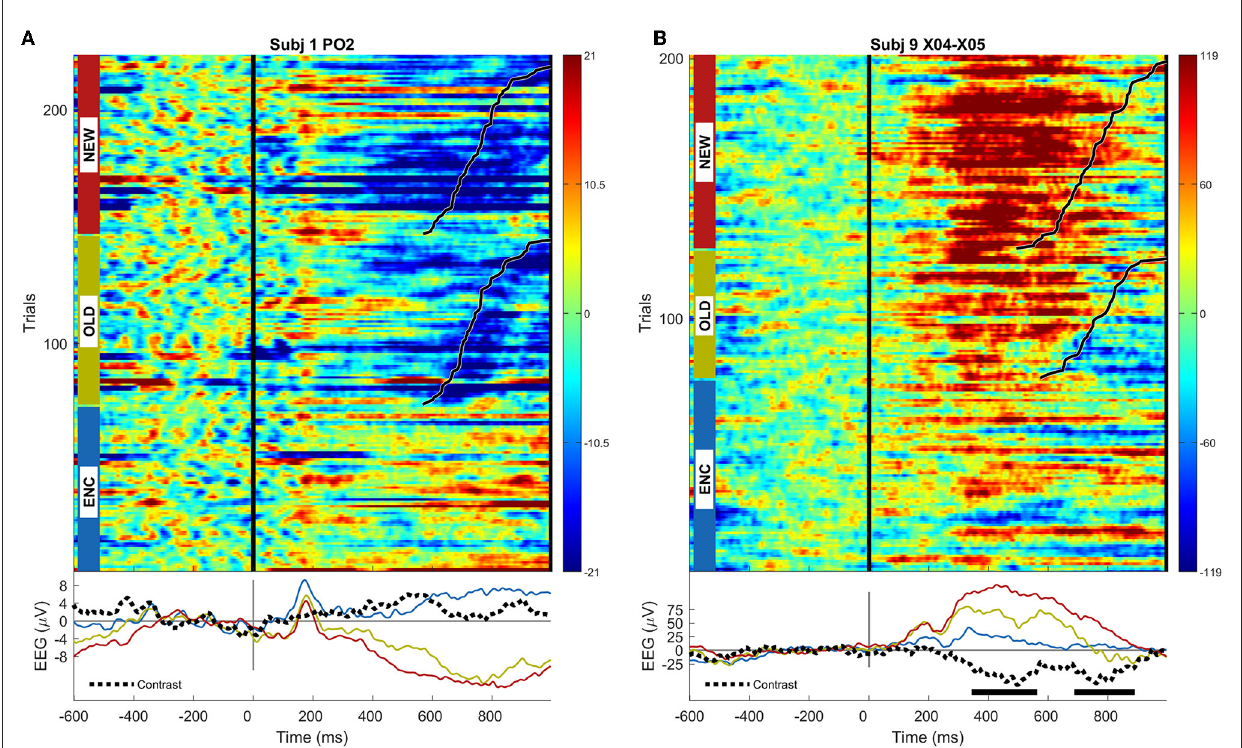
FIGURE2 (A) ERP image for the scalp sensor PO2 in subject 1, exhibiting the highest multivariate activation pattern; trials are grouped by condition and sorted by the response time, marked using black lines; average ERPs for each condition, as well as the contrast between OLD and NEW conditions, are shown; the statistical significance of the univariate (permutation cluster test) difference, if present, between OLD and NEW conditions at a significance level p < 0.05 is shown using thick horizontal lines; (B) same as (A) , but for the intracranial sensor X04-X05 located in right anterior insula in subject 9.